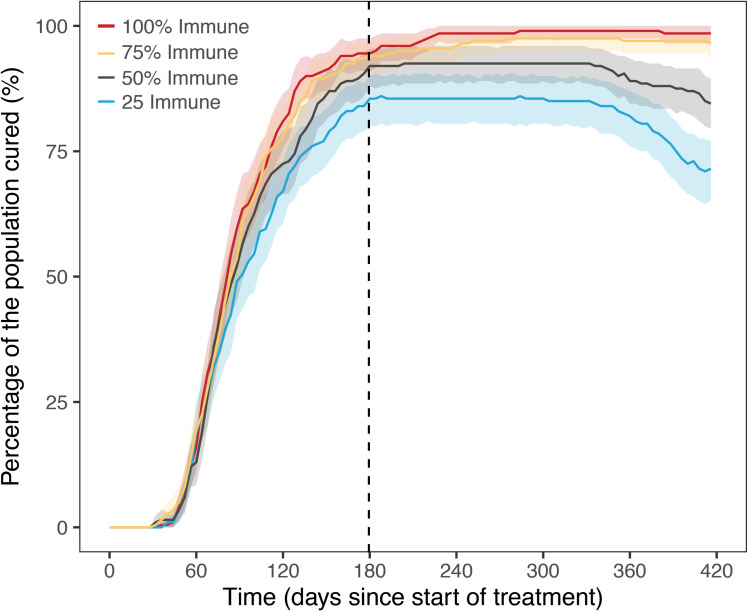
Population TB treatment outcome for reduced immune strength.Comparison of median patient outcomes for treatment of TB infection, with standard drug therapy (2HREZ/4HR) and patients with reduced immune response calculated as a percentage of full immune system present. Based on simulation of 5000 patients. Infection occurs 180 days before treatment.